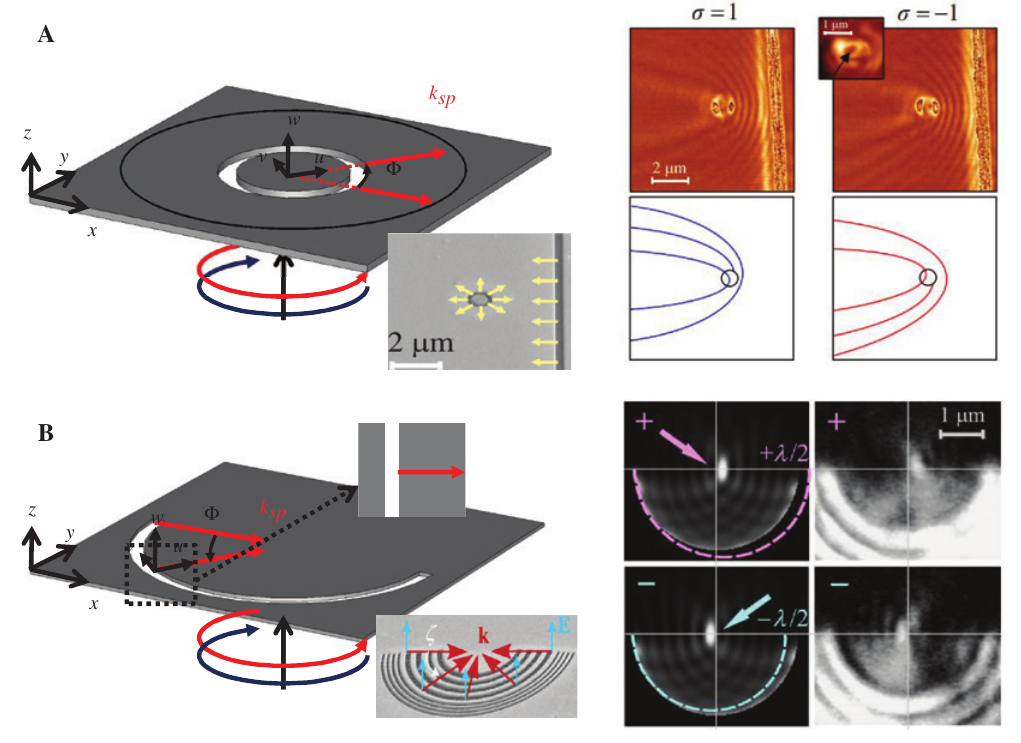
Figure 6: SPP generation by circular slit. (A) Circular nanoslot in generating spin-dependent outgoing surface waves. Interference fringes between the surface wave with a traveling plane wave for the two CP incidences are shown on the right. Reprinted from Ref. [87]. (B) Semicircular nanoslot in focusing surface waves. The spin-splitting of the focal spot is shown on the right. Reprinted from Ref.